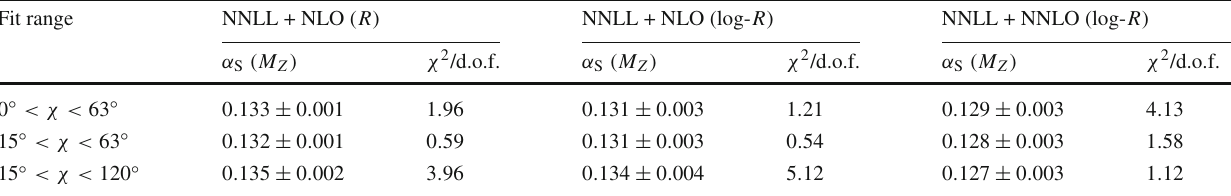
Table 1 Results of the fits of the matched predictions at NNLL + NLO and NNLL + NNLO accuracy to OPAL and SLD data. The number of degrees of freedom of the fits are d.o.f. = 50 for 0 ◦ < χ < 63 ◦ , d.o.f. = 38 for 15 ◦ < χ < 63 ◦ and d.o.f. = 86 for 15 ◦ < χ < 120 ◦ Fit